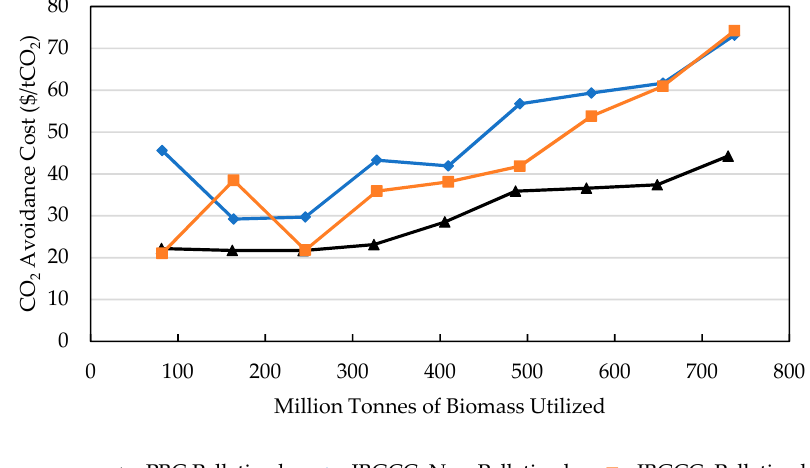
Figure 7. CO 2 avoidance cost (in $ per tonne of CO 2 avoided) of BECCS using an IBGCC power plant fueled by corn stover-derived syngas as a reference case.